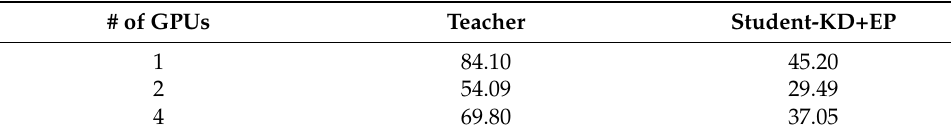
Table 10. Comparison of time taken to translate the test set in seconds. # of GPUs Teacher